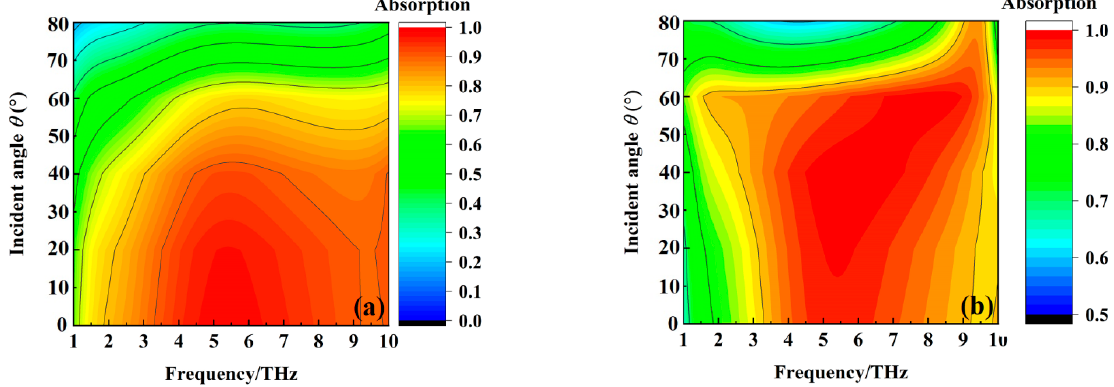
Figure 9. The absorption of the metamaterial absorber when the conductivity of VO 2 film is 2 × 10 5 S/m at different incident angles at TE and TM mode. ( a ) TE mode; and ( b )TM mode.